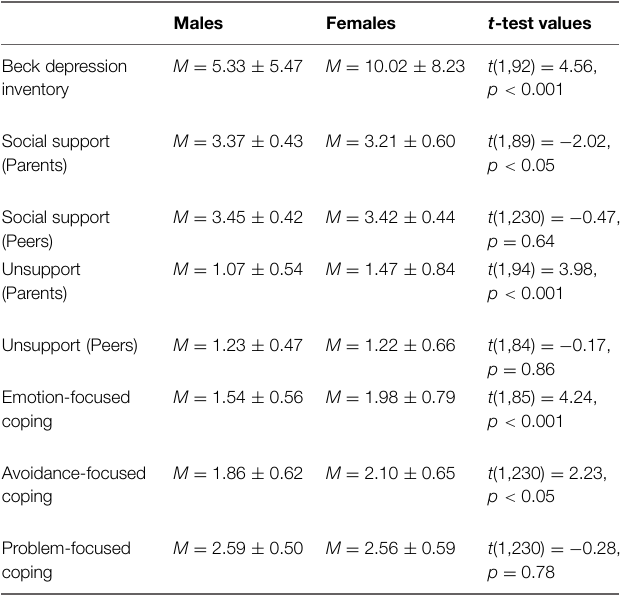
TABLE 2 | Mean, SD, and t -test values of study variables by gender. Males Females t -test values